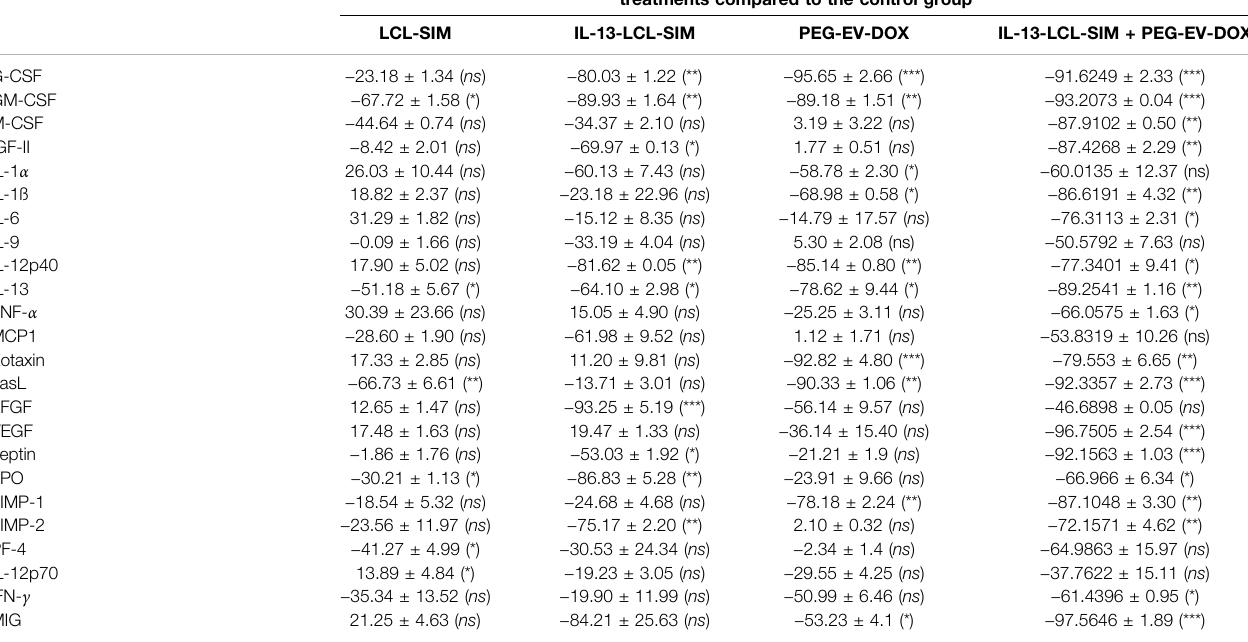
TABLE 4 | Effects of the nano-formulations on the production of angiogenic and in fl ammatory proteins in B16/F10 melanoma tumors. Angiogenic/in fl ammatory proteins Percentage of inhibition ( − ) and stimulation (+) of angiogenic/in fl ammatory protein production after different treatments compared to the control